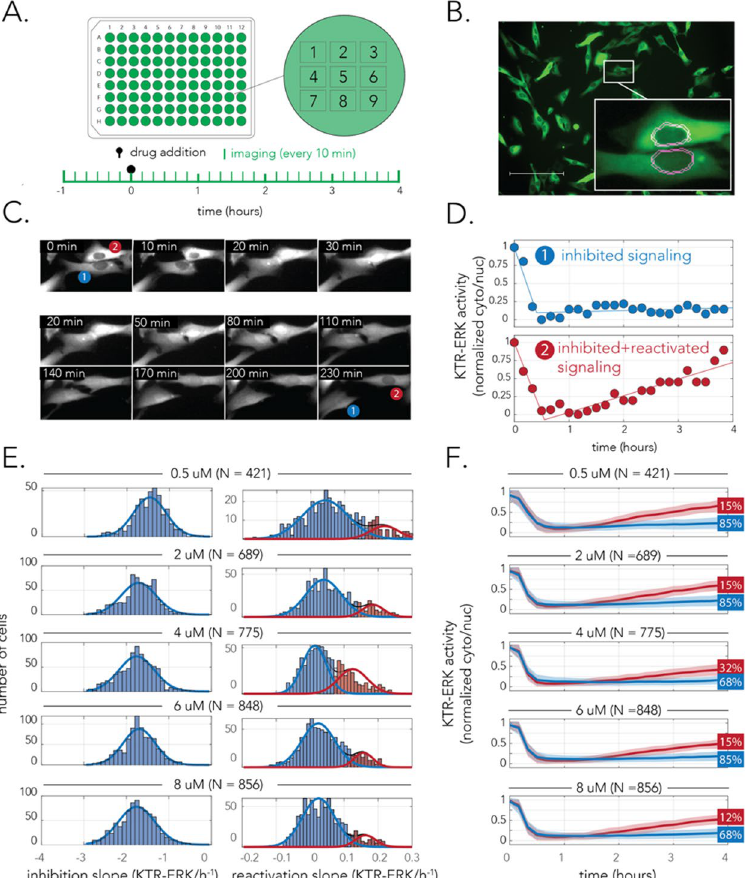
Figure 3. Single-cell measurements of signaling reveal homogenous inhibition yet heterogeneous signaling reactivation in WM983B cells. ( A ) A diagram of the drug treatment and imaging protocol. Cells were plated in a 96-well microplate and were imaged every 10 min over 4 h after drug treatment. ( B ) Representative microscopy image of the translocation fluorescent reporter used to monitor ERK signaling. Image analysis was used to segment both the nucleus region of each cell and a narrow ring surrounding it (to evaluate reporter intensity in the cytoplasm). ( C ) Microscopy images of changes in KTR-ERK in two neighboring cells after drug treatment. Upon 20 min of treatment the fluorescent reporter translocated to the nucleus in both cells (indicating ERK signaling is inhibited). The reporter partially translocated back to the cytoplasm after a few hours in cell #2. ( D ) Quantification of reporter localization in the two cells shown in ( C ) over time reveals different signaling reactivation in neighboring cells. The markers show the ERK activity relative to the range observed during the experiment as determined by the KTR-ERK reporter. The lines show the two-phase linear model that was fitted to the data points collected. Signaling reactivation starts as early as after 1 h in cell #2 while signaling remains inhibited in cell #1. ( E ) Cellular heterogeneity is observed in signaling reactivation but not in initial signaling inhibition. The histograms show the slopes of signaling inhibition (left panels) and signaling reactivation (right panels) across hundreds of co-cultured cells. The histograms were fitted to both unimodal and bimodal gaussians to test for heterogeneity and determine if dynamics were homogenous (unimodal) or heterogeneous (bimodal) with a statistical test. The histograms are colored with one or two colors according to the fit result and the underlying distributions are shown in thin blue and red lines. ( F ) Signaling profiles of all cells grouped and colored according to the bimodal distributions of signaling reactivation. The lines mark the average signaling status for the cell group and the shaded area shows the standard deviation. The numbers at the end of the graphs show the percentage of cells belonging to the cell